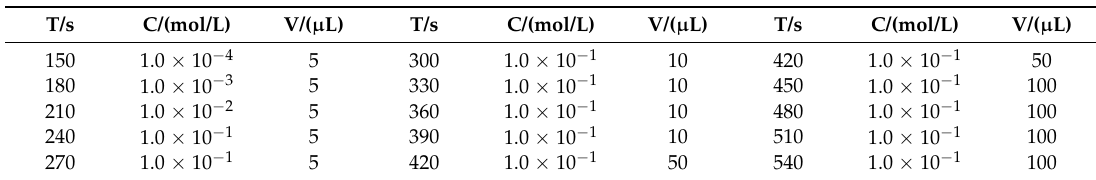
Materials 2017 , 10 , 868